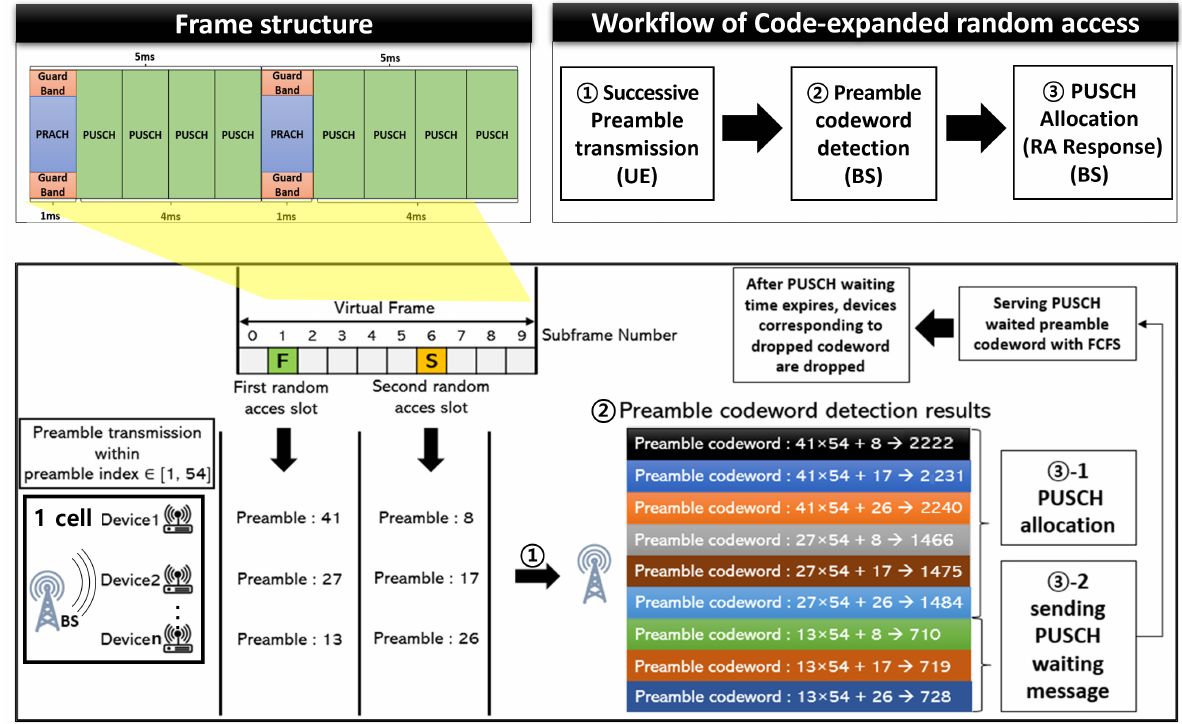
Figure 1. System